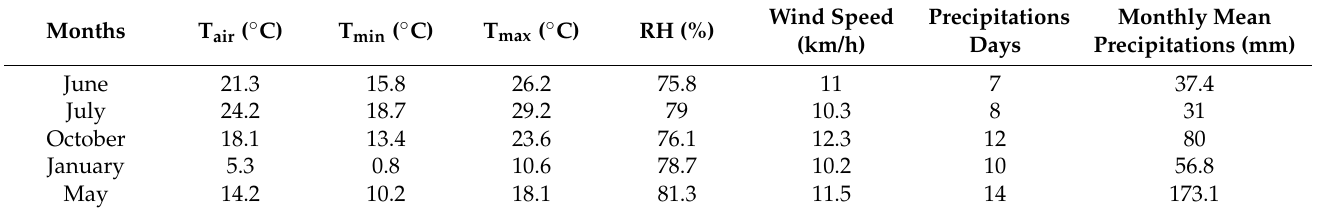
Table 1. Environmental conditions during the experimental period between June 2018 and May 2019. Meteorological data recorded with an automatic weather station: monthly mean air temperature (T air ); maximum (T max ) and minimum (T min ) monthly air temperatures; monthly mean relative humidity (RH); wind speed, number of rain days and monthly mean precipitations (mm).